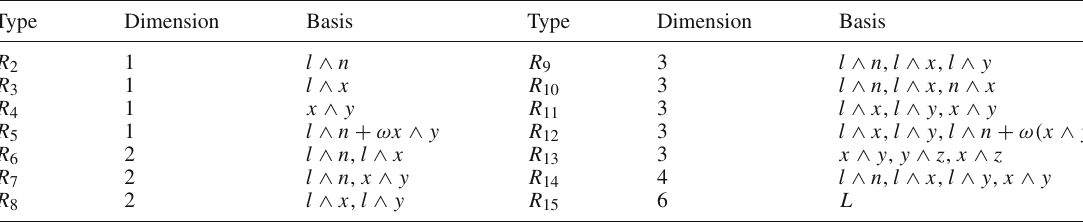
Table 1 Subalgebras of o ( 1 , 3